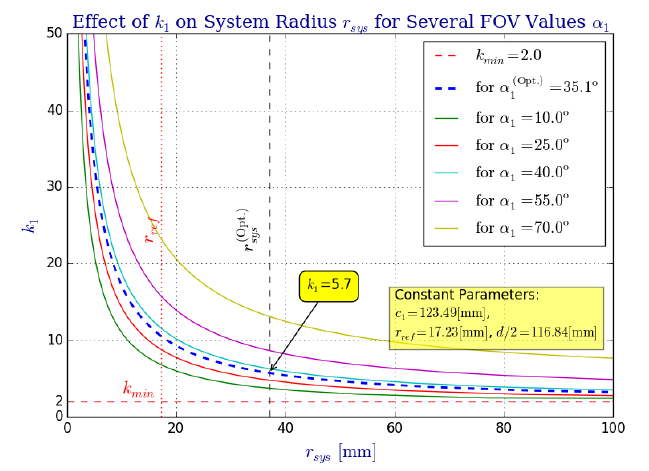
Figure 9. The effect that parameter k i (showing mirror 1 only) has over the system radius r sys for various values of the vertical field of view angle α 1 . In order to maintain a vertical field of view α i that is bounded by z max | r , the value of r sys must change accordingly. Inherently, the system’s height, h sys , sys and its mass, m sys , are also affected by k i (see Section 2.3).